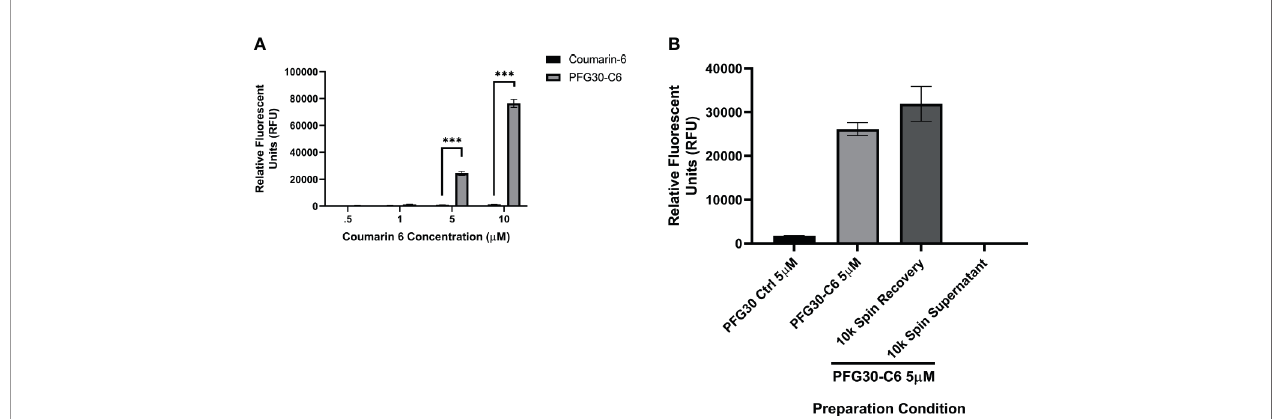
FIGURE 1 | Encapsulation of hydrophobic molecules in PFG30 increases their solubility. (A) Increasing concentrations of C6 alone or PFG30 + C6 was measured at 420 nm excitation and 500 nm emission. (B) 50 µM PFG30-C6 preparations were centrifuged after which the supernatant fl uid and pellets were diluted to 5 µM for measurement of fl uorescence at 420/500 nm. Experiments were run in triplicate with at least two technical replicates each. Statistical signi fi cance was determined by two-way ANOVA in GraphPad Prism 8 with the Holm- Š ídák posthoc test for multiple comparisons (***p-value <